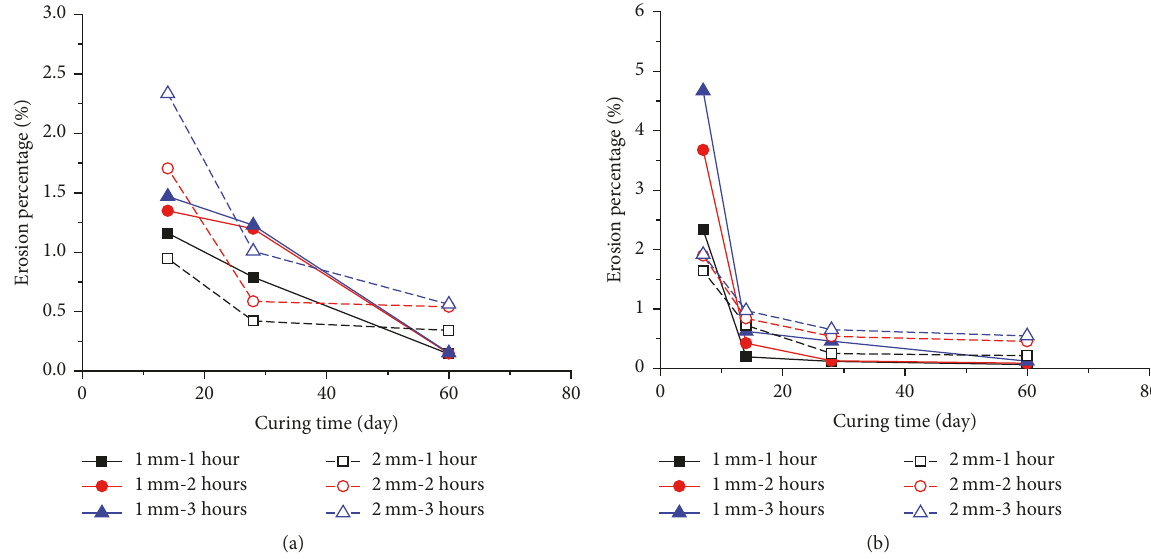
Figure 6: Erosion percentage against curing time for (a) CB-PFA samples and (b) CB-GGBS